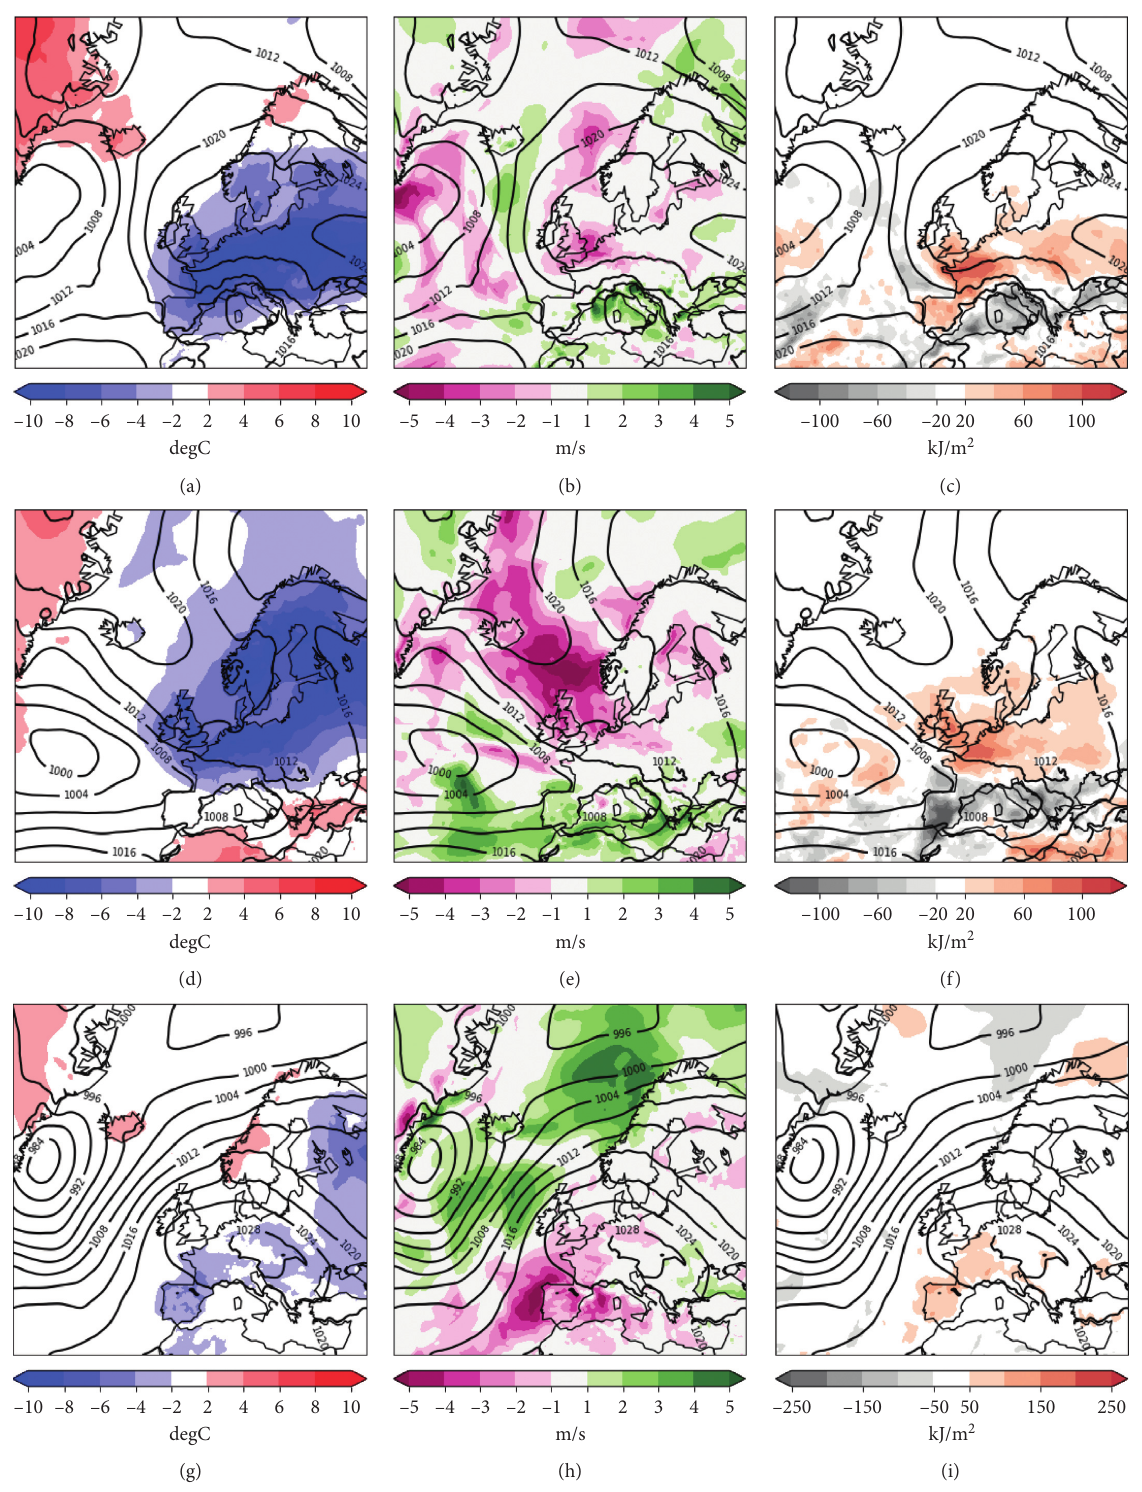
Figure 4: Meteorological anomaly composites of the top 10 peak demand events net of renewables (DNR) for (a–c) France, (d–f) the UK, and (g and h) Spain. Columns show (left) 2 m temperature, (middle) 100 m wind speed, and (right) surface solar radiation. Note different scales in (i) relative to (c) and